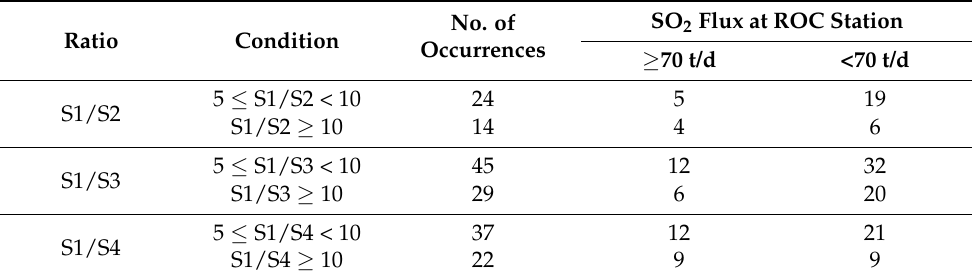
Table 1. Total number of days during the May 2018–May 2021 period when the ratios between observations of total SO 2 VCD at the single pixel (S1) and within the averaging windows (S2: 3 × 3, S3: 5 × 5 and S4: 4 × 2) exceeded the selected thresholds. Such occurrences are then distinguished according to the number of days when low (<70 t/d) and medium to very high ( ≥ 70 t/d) SO 2 flux was detected at ROC station. SO 2 Flux at ROC Station No. of Ratio Condition Occurrences ≥ 70 t/d <70 t/d 5 ≤ S1/S2 < 10 24 S1/S2 S1/S2 ≥